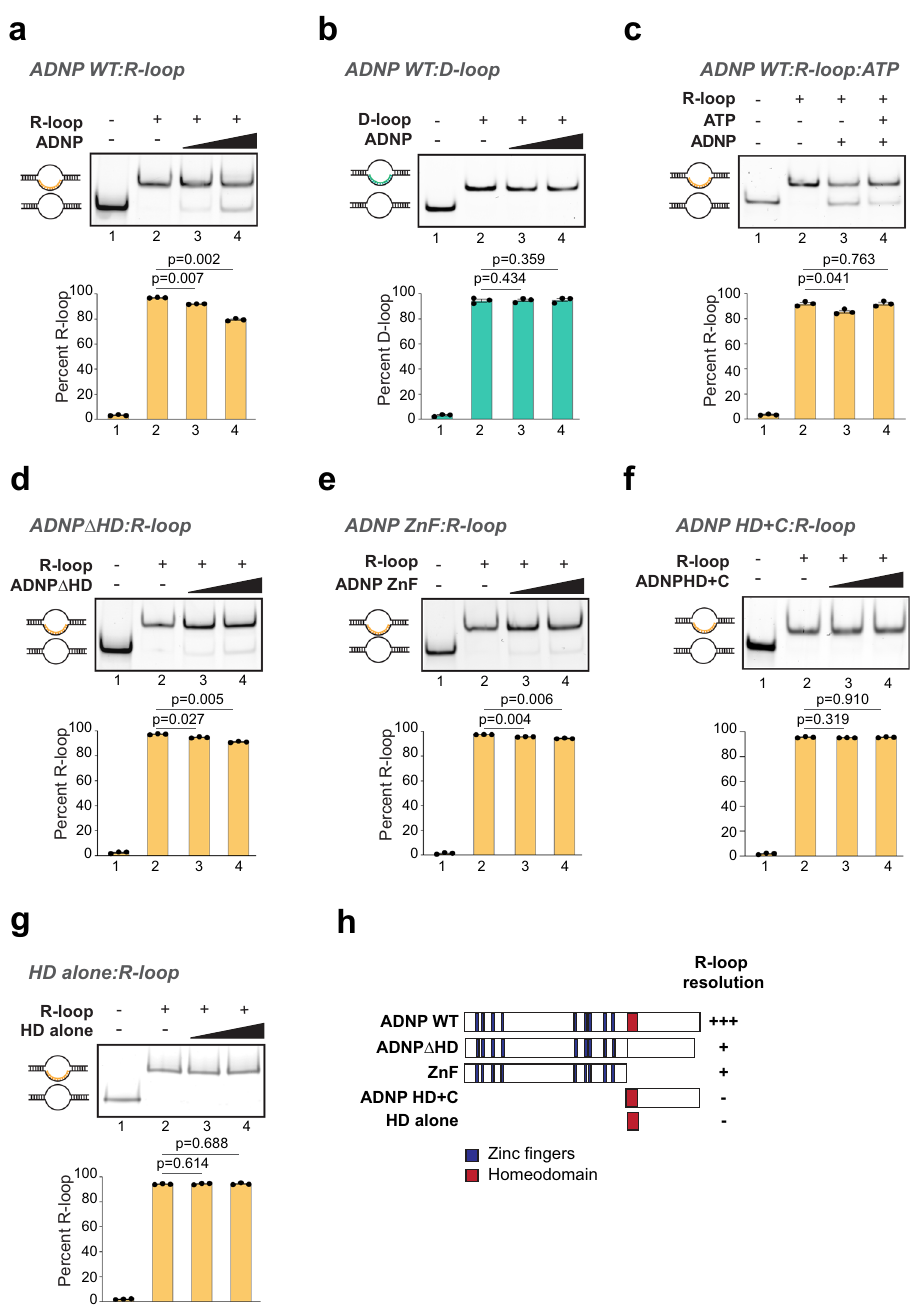
Fig. 4 ADNP resolves R-loop structures in vitro. a R-loop resolution assay with 40 nM and 200 nM ADNP WT and 1 nM R-loop substrates. Positions of duplex and R-loops are shown. For all resolution assays, quanti fi cation of 3 independent experiments is shown as mean values ± SEM. Two-sided Student ’ s t test p -values are shown. b D-loop resolution assay with 40 nM and 200 nM ADNP WT and 1 nM D-loop substrates. Positions of duplex and D-loops are shown. c R-loop resolution assay with 200 nM ADNP WT and 1 nM R-loop substrates without or with ATP as indicated. d R-loop resolution assay with 40 nM and 200 nM ADNP Δ HD and 1 nM R-loop substrates. e R-loop resolution assay with 40 nM and 200 nM ADNP ZnF and 1 nM R-loop substrates. f R-loop resolution assay with 40 nM and 200 nM ADNP homeodomain and C terminus and 1 nM R-loop substrates. g R-loop resolution assay with 40 nM and 200 nM ADNP homeodomain alone and 1 nM R-loop substrates. h Summary of R-loop resolution activities of full-length ADNP WT, ADNP Δ HD, ADNP ZnF, ADNP HD + C, and the homeodomain alone. Source data underlying ( a – g ) are provided as a Source data fi le. experiment, ADNP is unable to resolve D-loop structures ATPase domains. We reasoned that if R-loop resolution occurs (Fig. 4b). To con fi rm that our ADNP protein sample did not because of the presence of a contaminating ATP-dependent contain a contaminating ribonuclease, we incubated ADNP with helicase, resolution activity would be stimulated by the addition the RNA used to generate R-loop substrates and found that the of ATP. Interestingly, we found that the ability of ADNP to RNA strand remained intact and was not degraded (Supple- resolve R-loops is independent of ATP hydrolysis, and is instead mentary Fig. 4c). ADNP does not have annotated helicase or slightly inhibited by ATP (Fig. 4c, compare lanes 3 and 4). This NATURE COMMUNICATIONS| (2022) 13:53